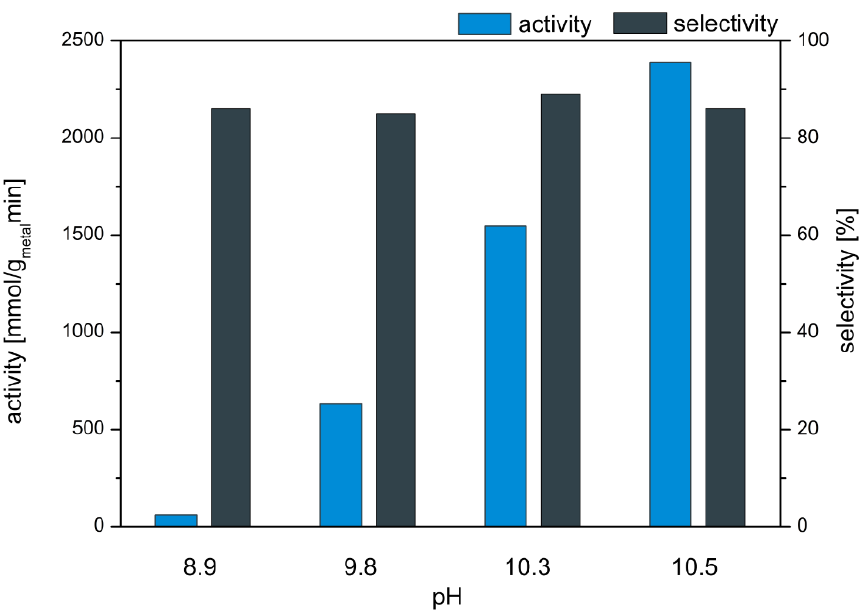
Figure 2. Influence of pH-value (8.9 – 10.5) on activity and selectivity in the oxidation of MEG to GA. Reactions conditions: 20 wt% MEG, 70 °C, 25 g/L catalyst (0.1 wt% AuPt(9:1)/CeO 2 ), pH 8.9 – 10.5 and 7 bar O 2 .